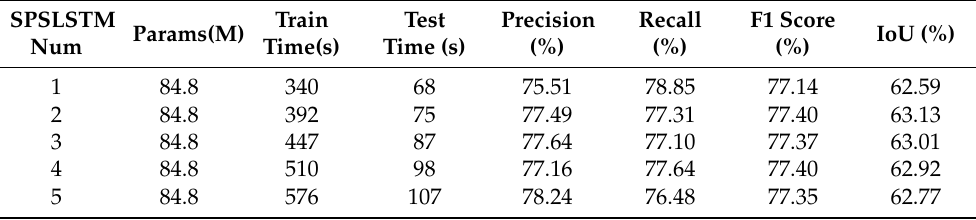
Table 5. Comparison of network performance with different numbers of SPCLSTM